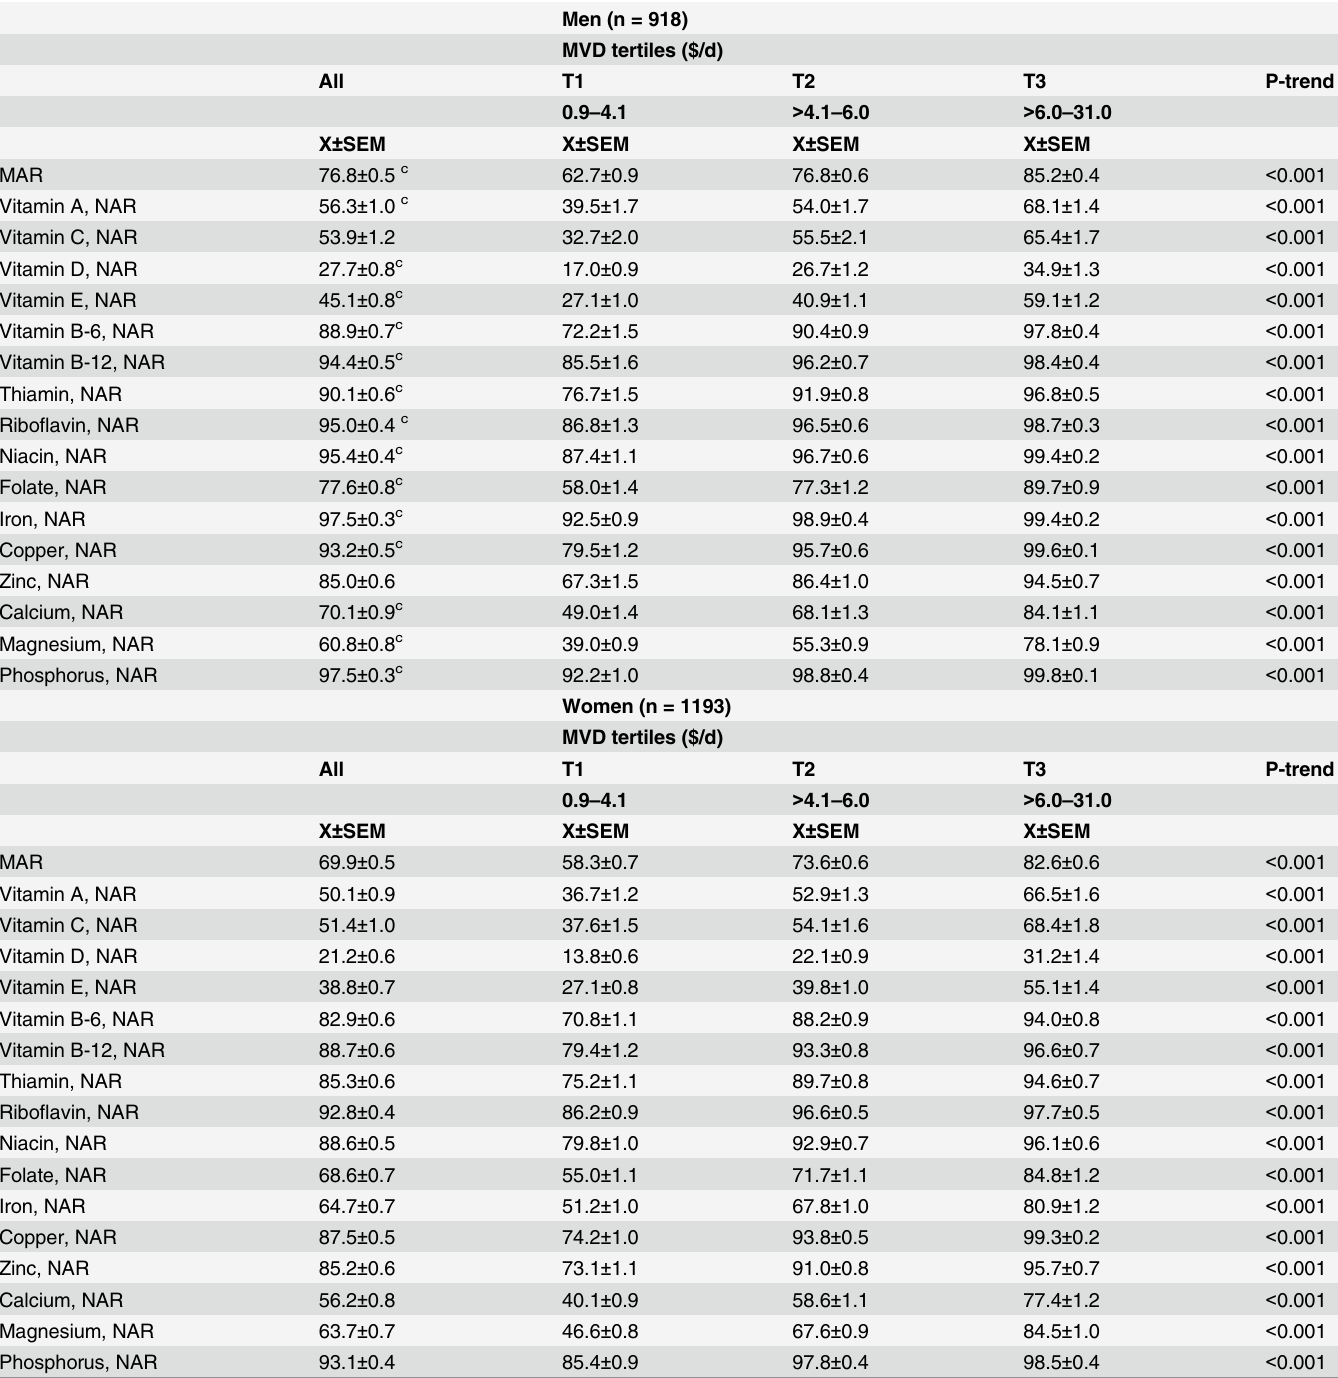
Table 3. Mean and Nutrient Adequacy Ratio (MAR and NAR) Scores a for HANDLS participants by monetary value of diet tertile and